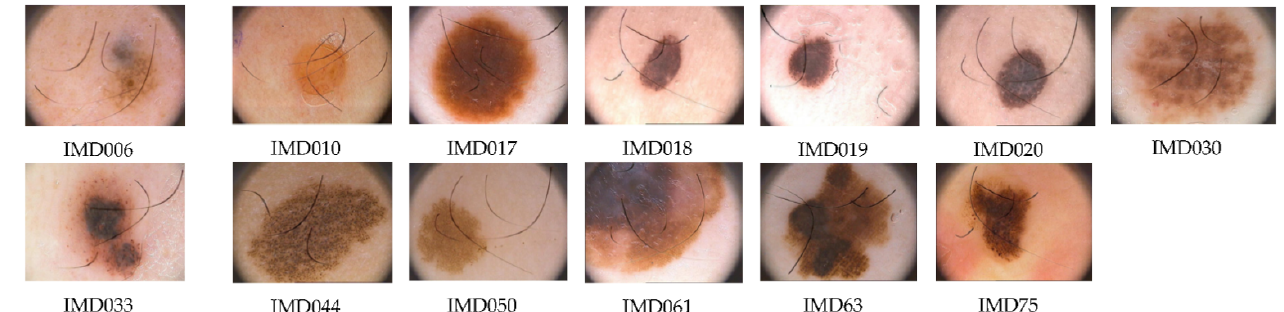
Figure 5. Image dataset H13GAN-data generated by applying the GAN method [38] to NH13-data and published in [37].